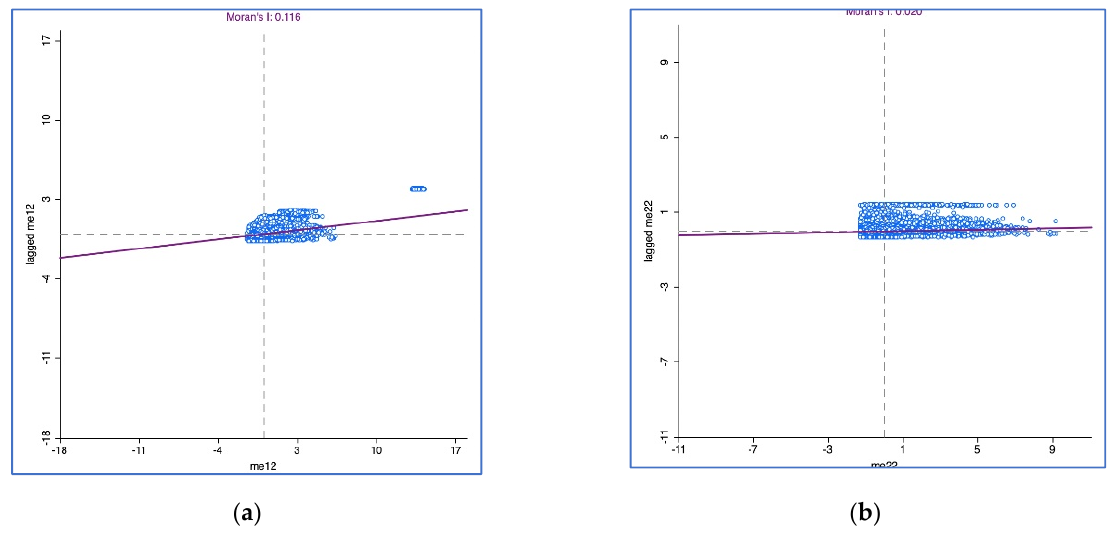
15 of 25 Table 3. Results of Moran’s I test on the baseline model residuals. Baseline Model